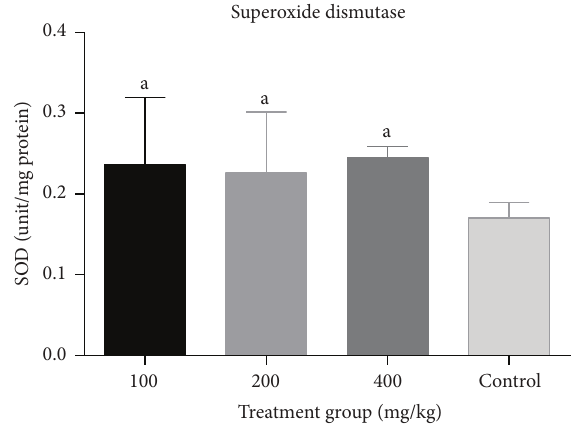
Figure 9: Effect of combined aqueous extracts of Azadirachta indica and Khaya senegalensis on superoxide dismutase activity (SOD) of the liver of healthy chickens. Values are expressed as mean ± SEM where 𝑛 = 5 . a Significant as compared with control ( 𝑝 < 0.05 ).